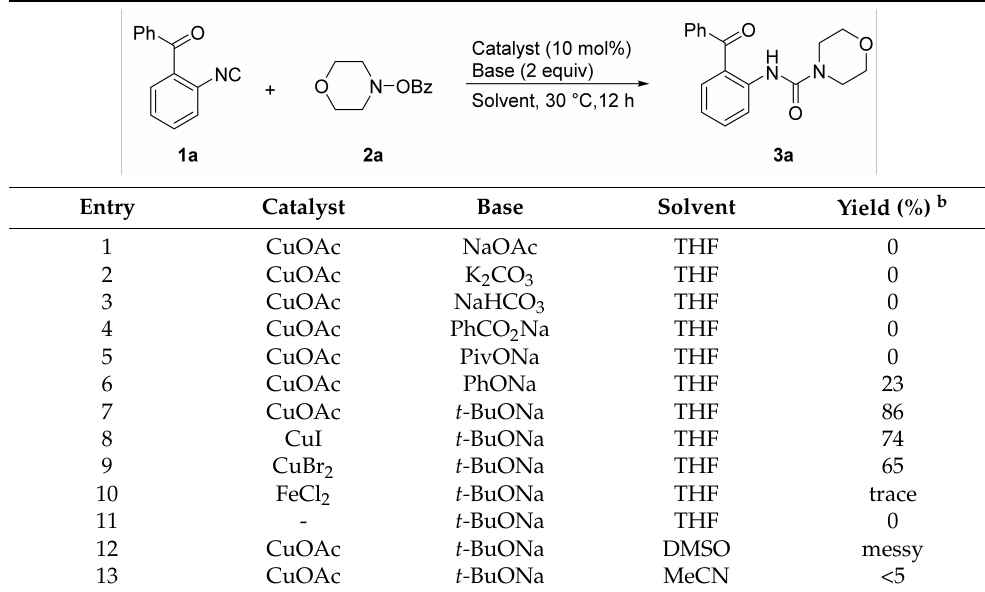
Table 1. Optimization for the Cu-catalyzed urea synthesis a